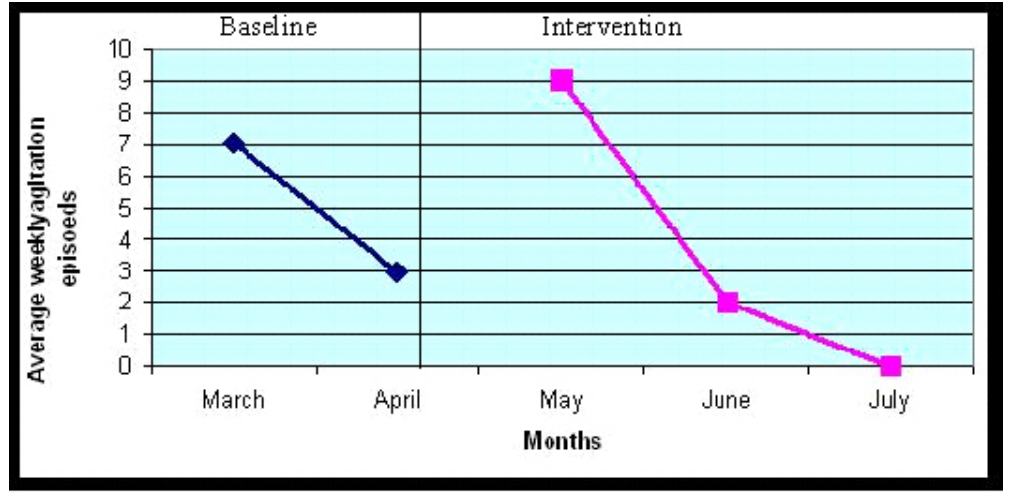
FIGURE 2. Case story one (DA): Changes in agitation behavior due to Snoezelen